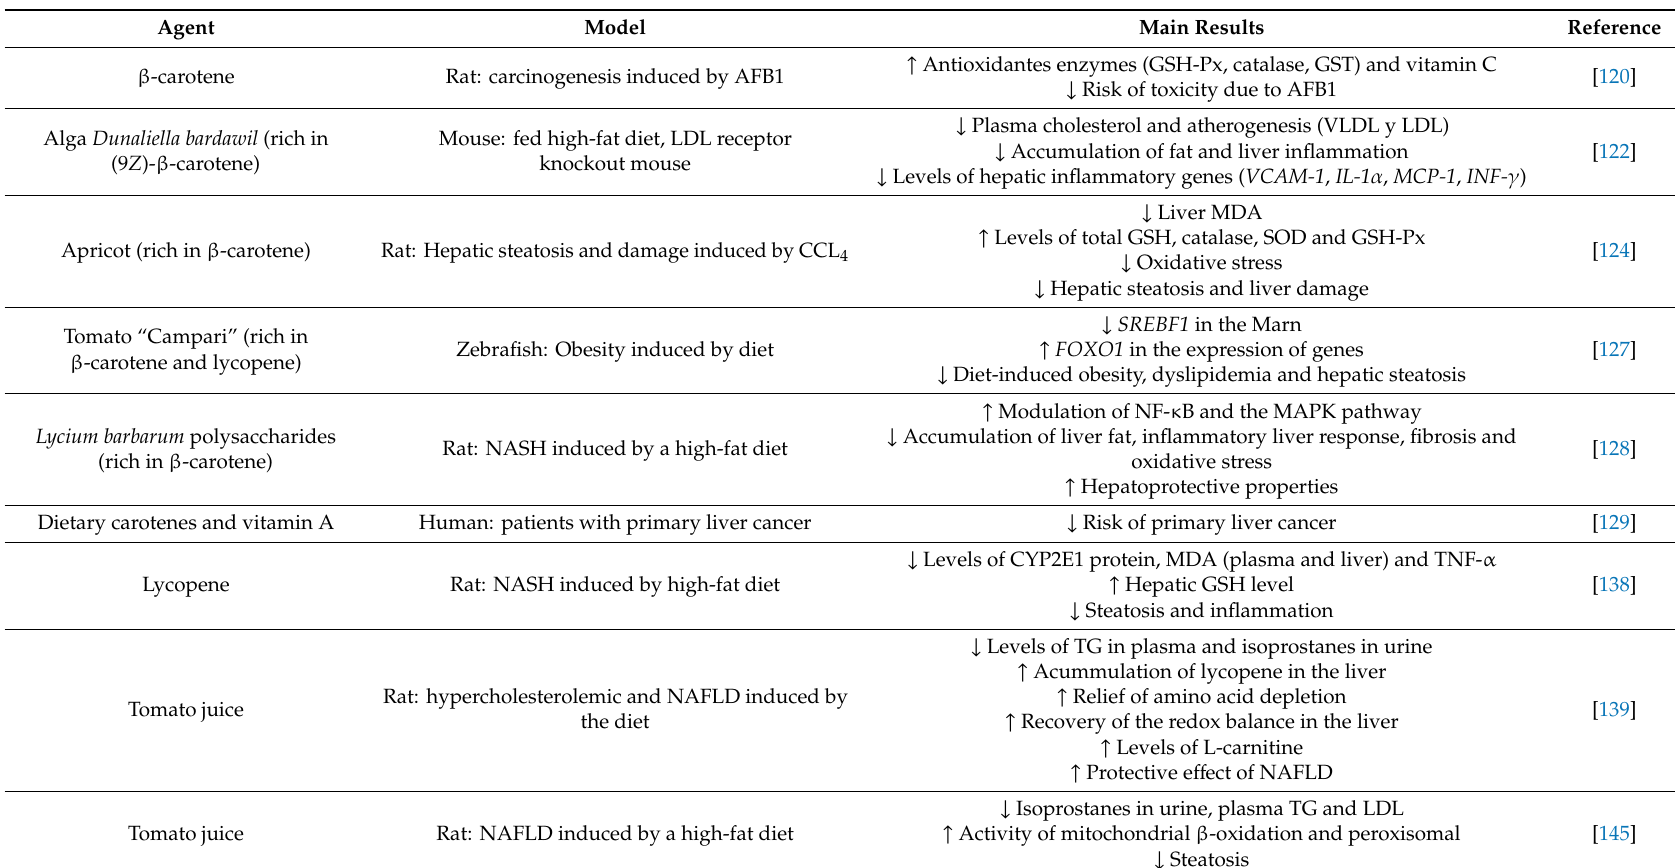
Table 3. Summary of studies in which carotenoids had a beneficial e ff ect on chronic liver diseases in cell lines, and human and animal